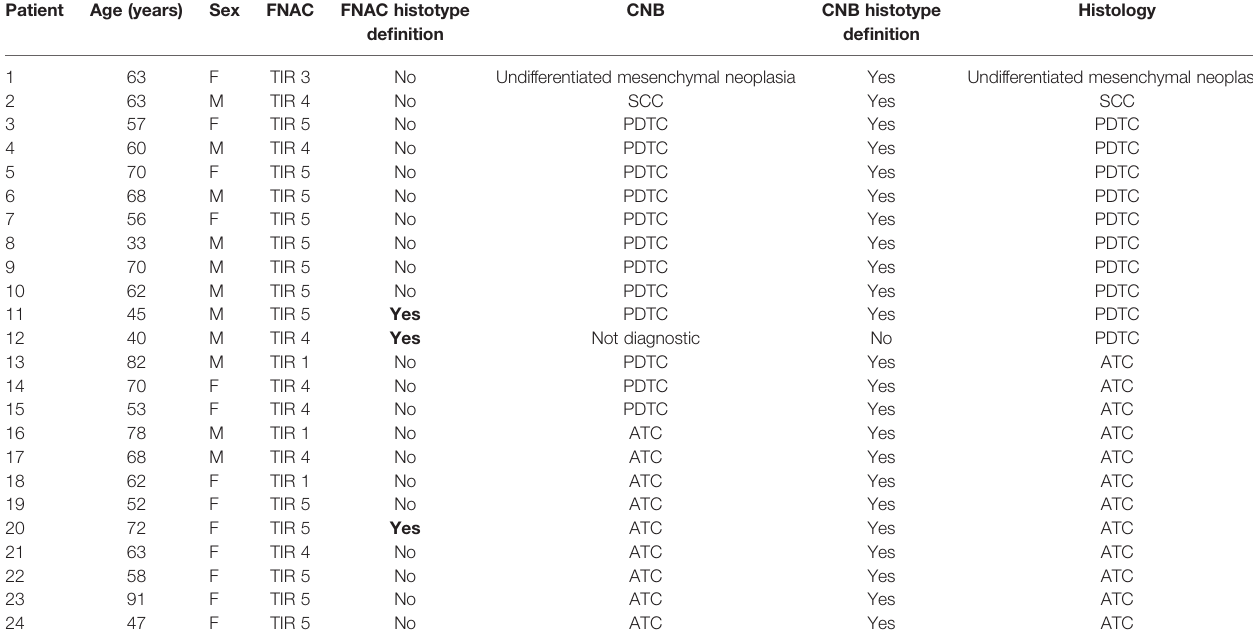
TABLE 5 | Diagnostic performance of FNAC and CNB compared with histology in patients treated with surgery ( n = 24). Patient Age (years)